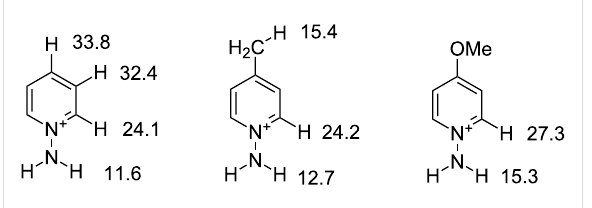
Figure 1: p K a values for N -aminopyridinium cation hydrogen atoms according to DFT M06-2X 6-31+G(d,p)